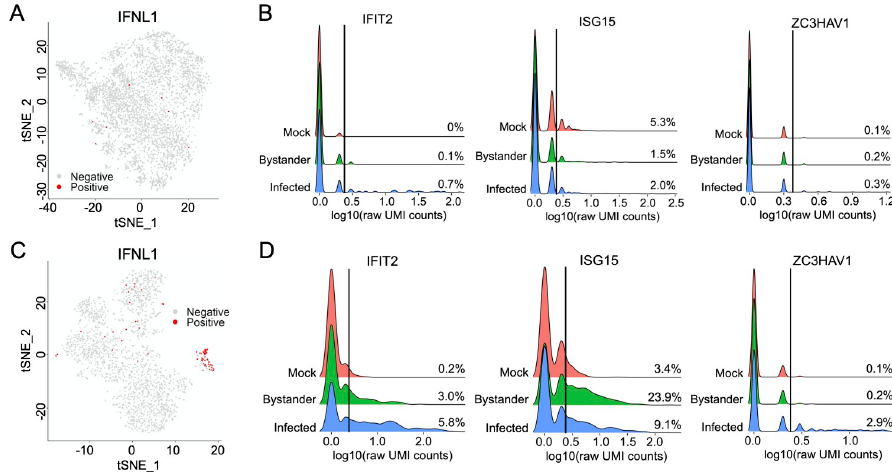
Fig 7. H1N1 and H3N2 strains differ significantly in single cell patterns of IFN and ISG transcription. (A) tSNE plots of all Cal07-infected A549 cells with cells that have detectable level of IFNL1 colored in red. (B) Histograms comparing distributions of per-cell UMI counts in log10 scale for the indicated host transcripts across the three libraries (mock, bystander, and infected) for Cal07 experiment. Cells with zero count excluded to avoid dominating the y-scale. Vertical lines indicate cutoff thresholds of 3 UMI counts, with percentages of all cells (including cells with zero count) in each library above the threshold shown on right. (C) Same figure as (A) for Perth09. (D) Same figure as (B) for